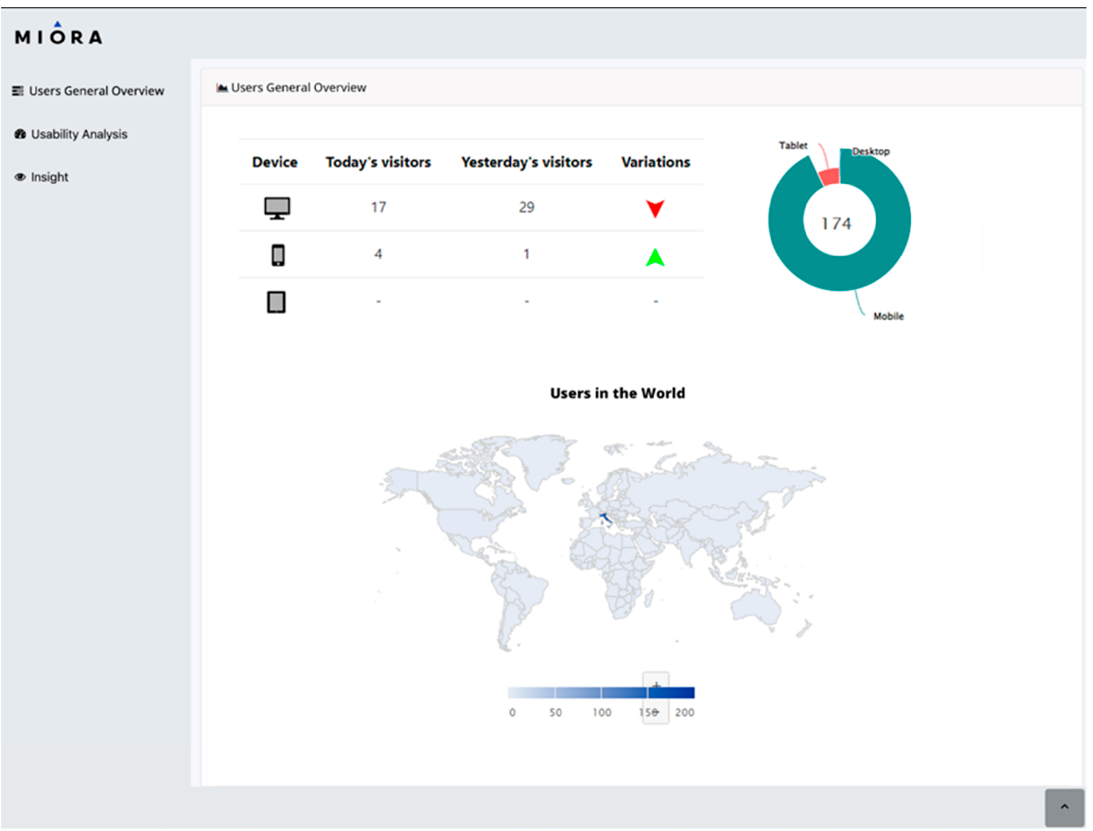
Figure 4. Users General Overview section of the Miora tool.